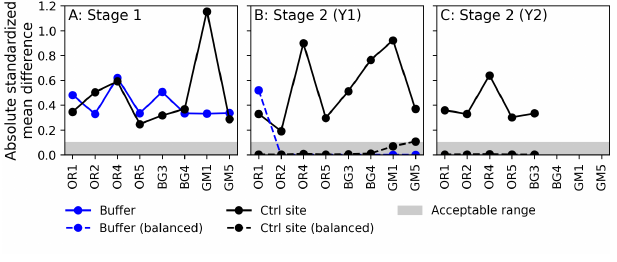
Fig. 6 . Indirect land use and land cover (LULC) change estimates and the effect of the two-stage treatment-control approach. The 0-stage distributions represent the probability of each LULC change outcome in points sampled from the treatment site buffer area only, 1-stage represents treatment/ control site differences, and 2-stage represents differences between treatment and reweighted control points. Box plot whiskers indicate 5% and 95% intervals on the estimates across the 100 sampling